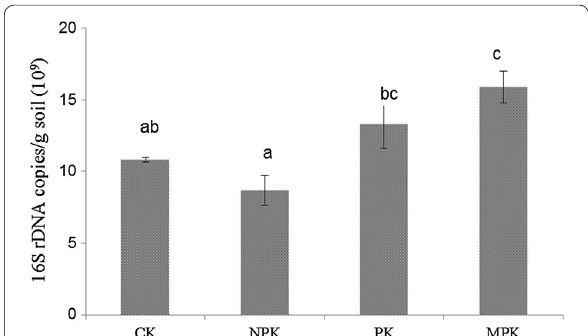
Fig. 1 Number of 16S rDNA copies in different fertilization regimes. Different lowercase letters above columns indicate significant differ- ences according to Tukey’s multiple comparison